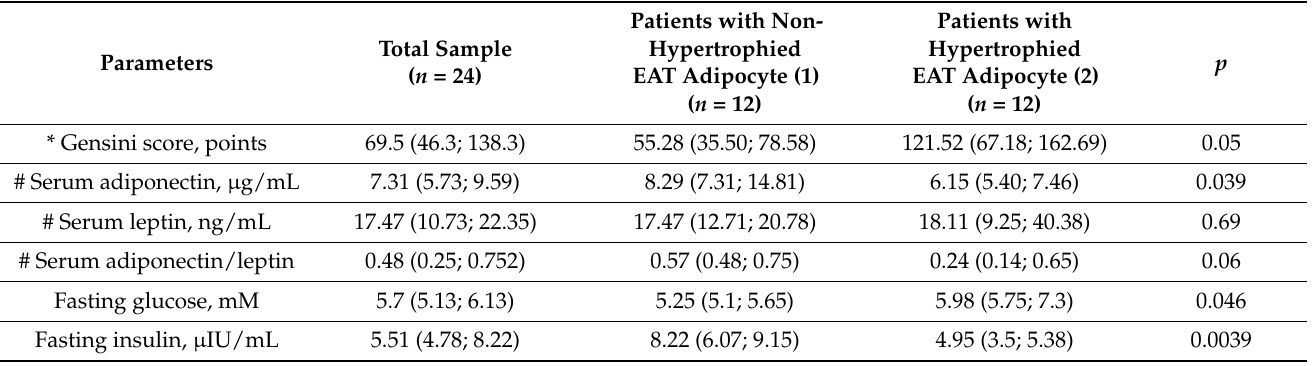
Table 4. Coronary artery disease severity and adipokine’s levels adjusted to gender and BMI depending on the hypertrophy of adipocytes of epicardial adipose tissue.